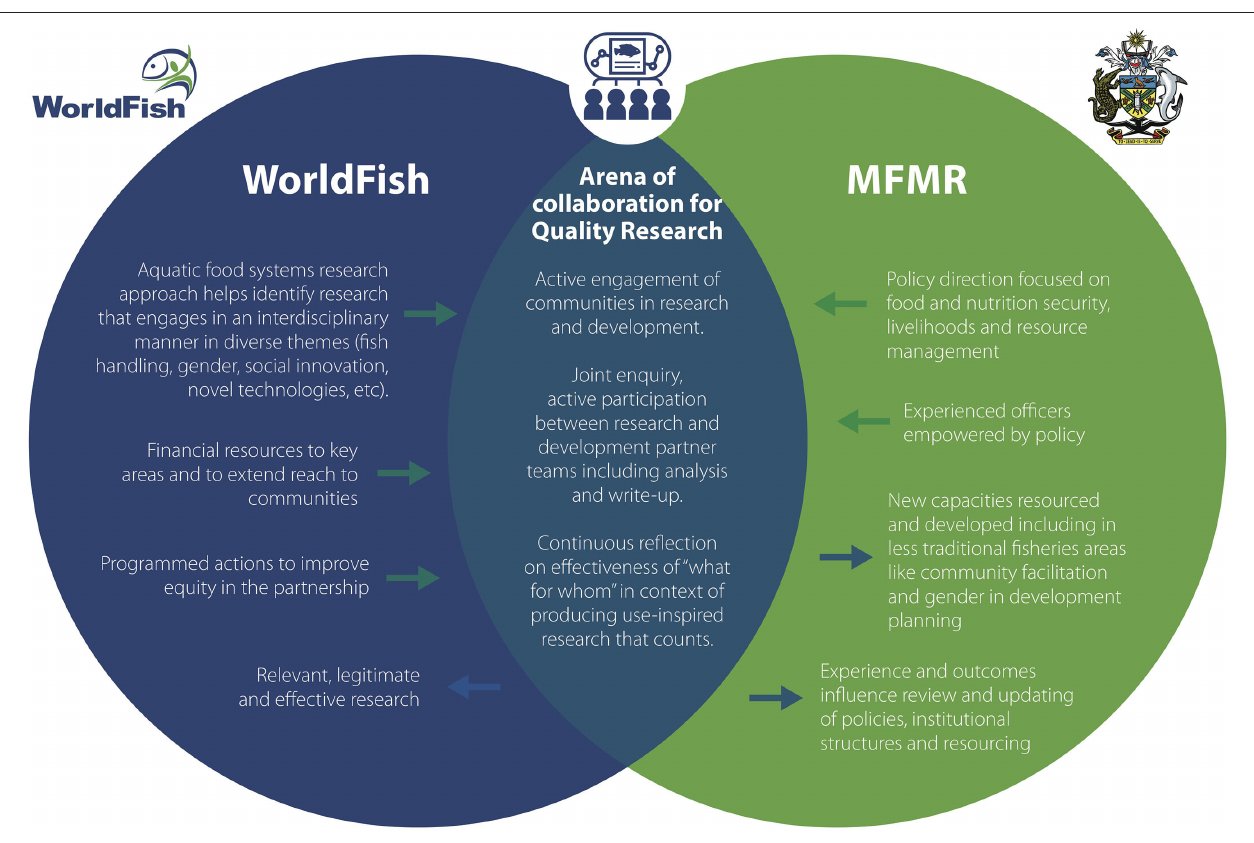
FIGURE 3 | The proposed interface of collaboration for high-quality research between WorldFish and the MFMR, specific to this research-development partnership